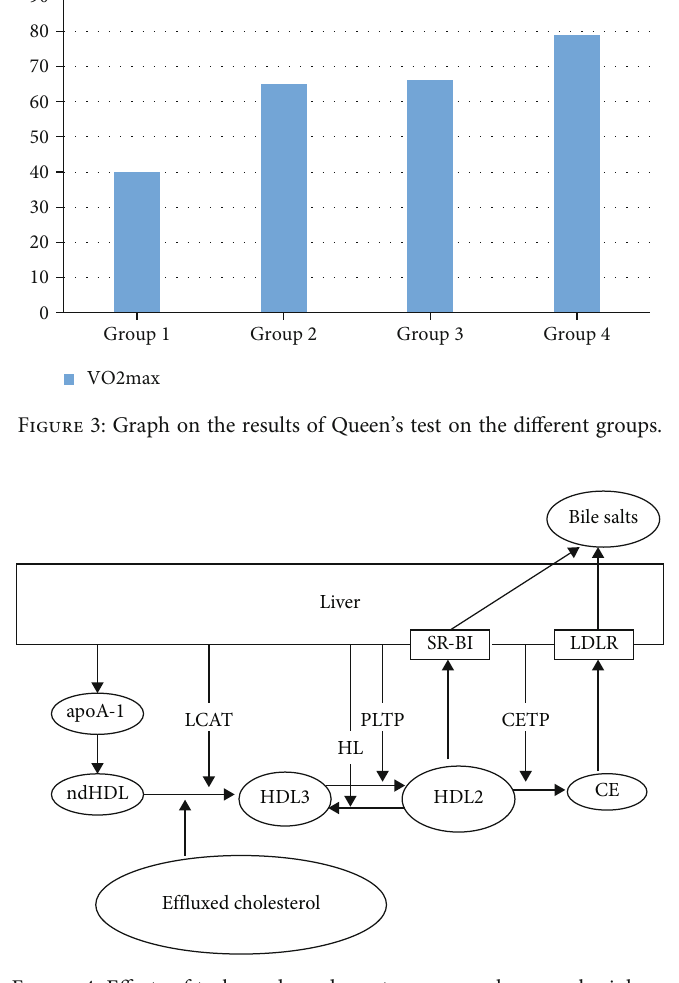
Figure 4: E ff ects of taekwondo and sports games on human